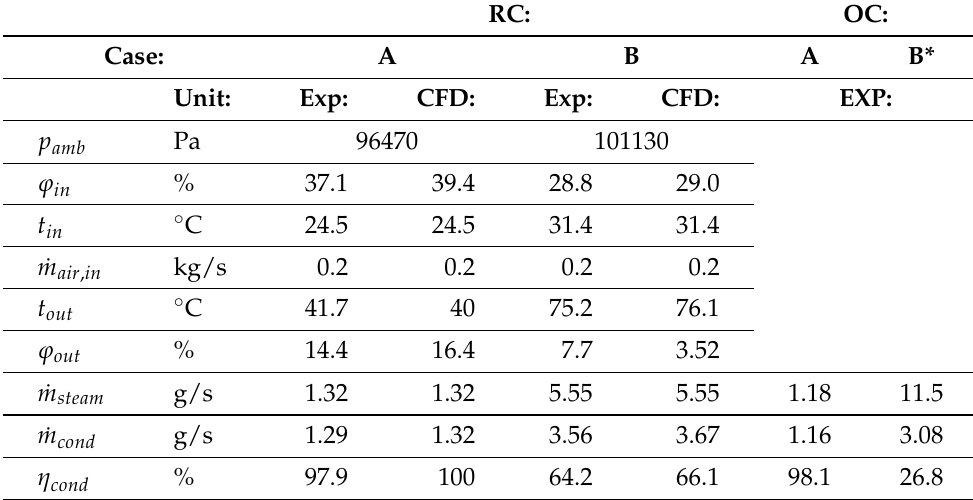
Table 2. Experimental and numerical results: RC—redesigned construction; OC—original construc- tion; Exp—experimental values; CFD—numerical